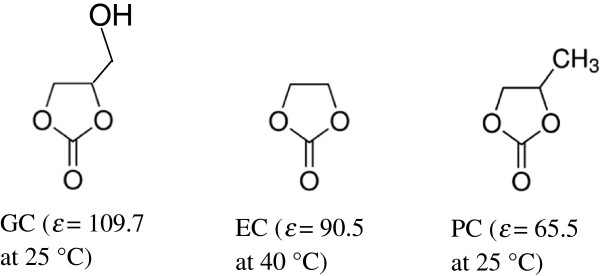
Molecular structures and 
ϵ 
values of GC, EC and PC [13].